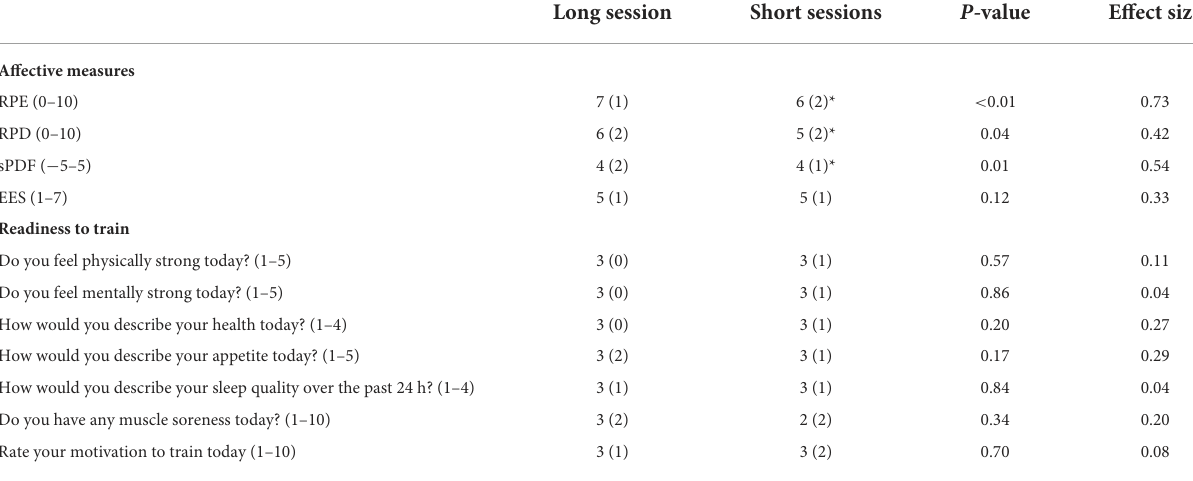
TABLE 2 Affective measures and readiness to train for the long and the short sessions [median (interquartile range)]. Long session Short sessions P -value Effect